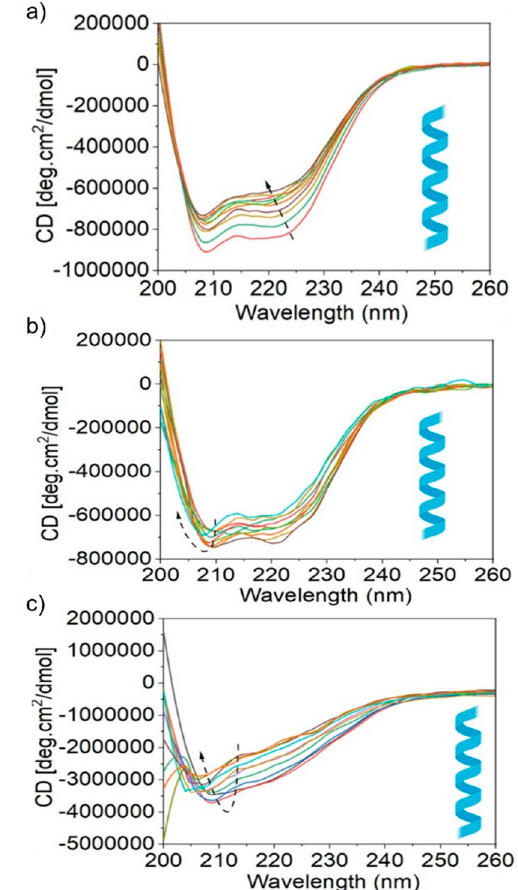
Figure 7. Circular dichroism (CD) spectra are demonstrating the secondary structure and conformational stability of the human blood plasma proteins albumin ( a ), fibrinogen ( b ), and transferrin ( c ) upon association with SiQDs/F127 nanoparticles (in the 0–2.25 µg/mL concentration range at 0.25 intervals). Arrows indicate the nature of spectral shift or change after the addition of nanoparticles with proteins.